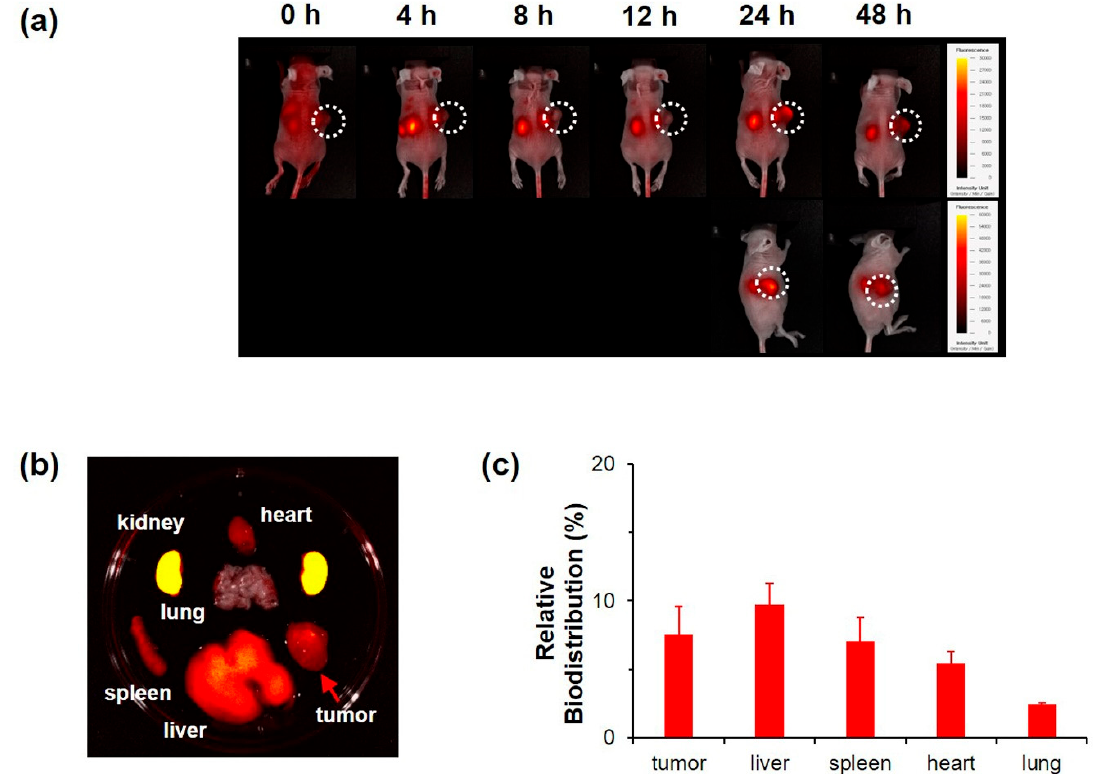
Figure 4. Non-invasive in vivo fluorescent imaging of Cy5.5-tagged NC 2 after intravenous injection into tail veins of single KB tumor-bearing nude mice. ( a ) Whole body imaging at predetermined time points after i.v. injection. ( b ) Ex vivo optical and fluorescent imaging of tumor and organs obtained 24 h post injection. ( c ) Relative biodistribution of NC 2 by quantitative fluorescence intensity (FI) of tumors and main organs.